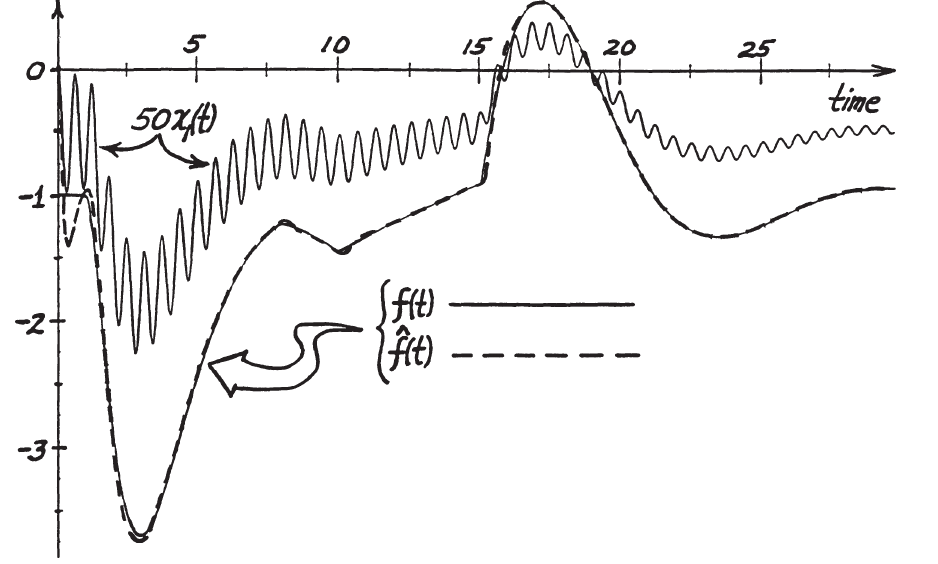
Fig. 1. Simulation results for the example [ x 1 (0) = x 2 (0) =